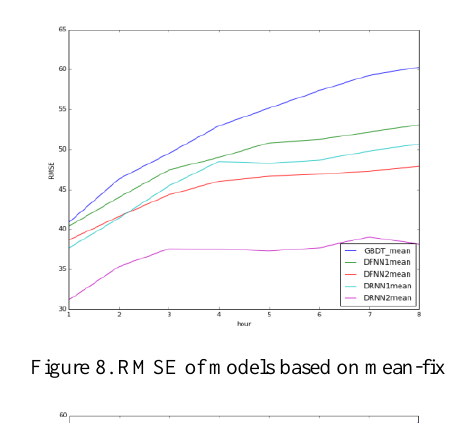
Figure 5. RMSE of DRNN1 models